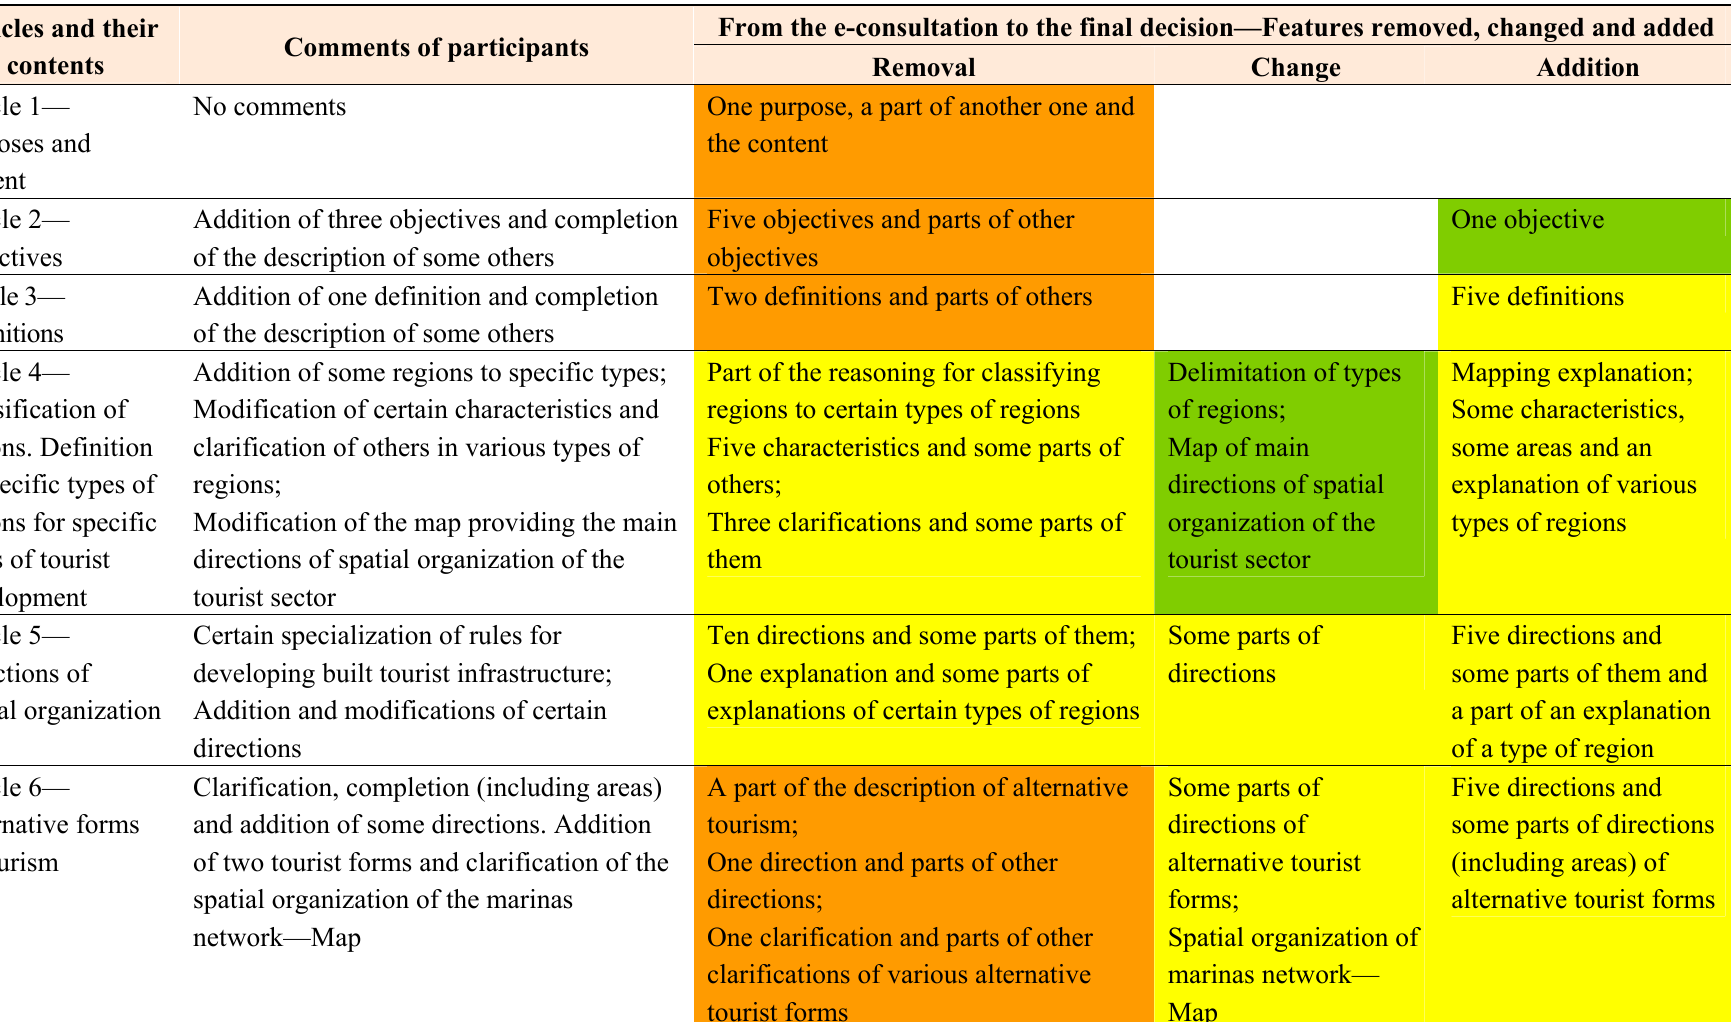
Table 2. “Mapping” the impact of public participation in the specific policy reform on the spatial development of the tourist